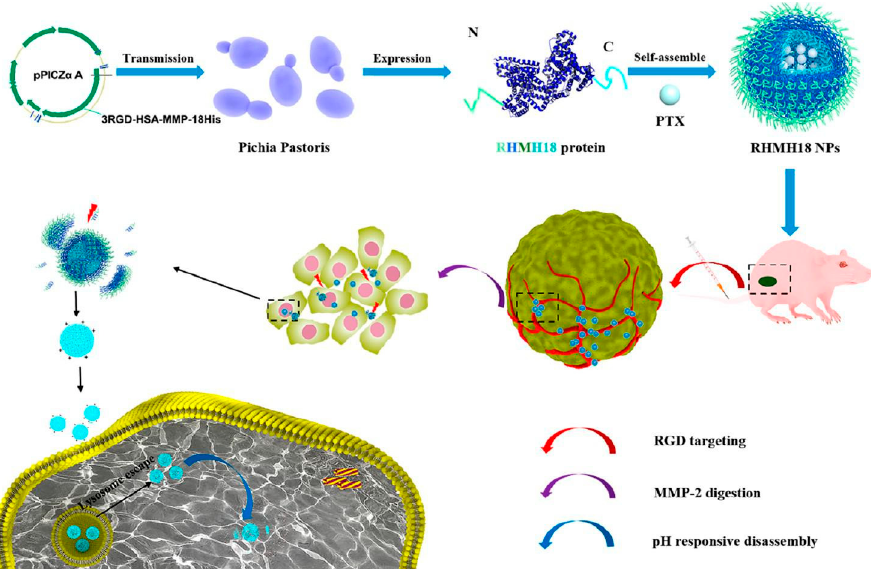
Figure 5. Schematic illustration of the design and application of self-assembling albumin nanoparticles for RGD-mediated tumor targeting. Copyright 2020 American Chemical Society [104].